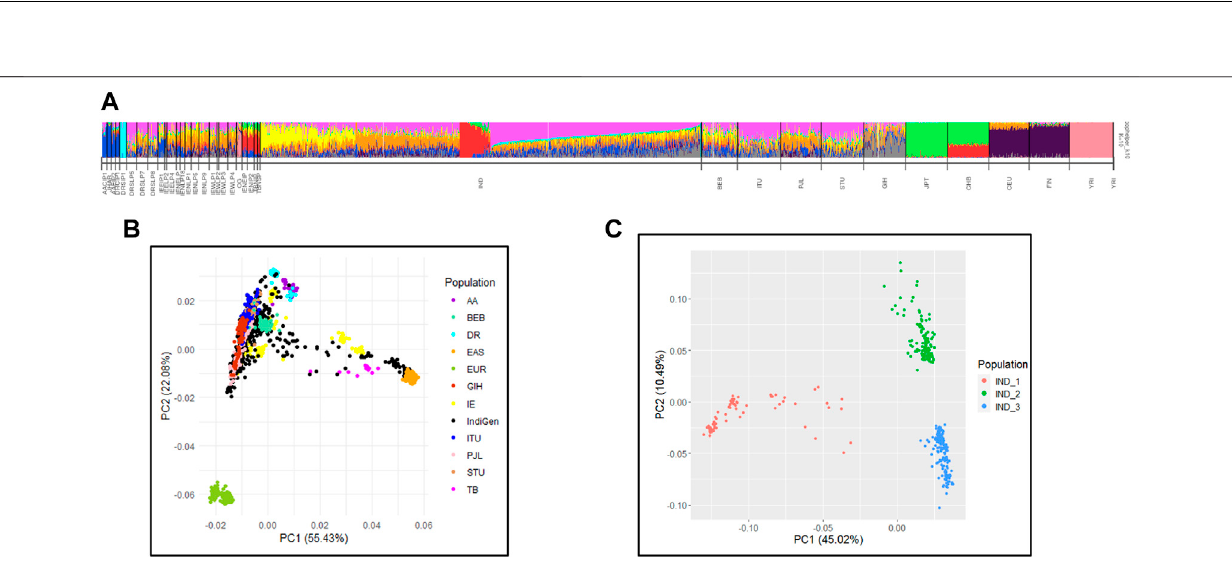
Frontiers in Genetics |